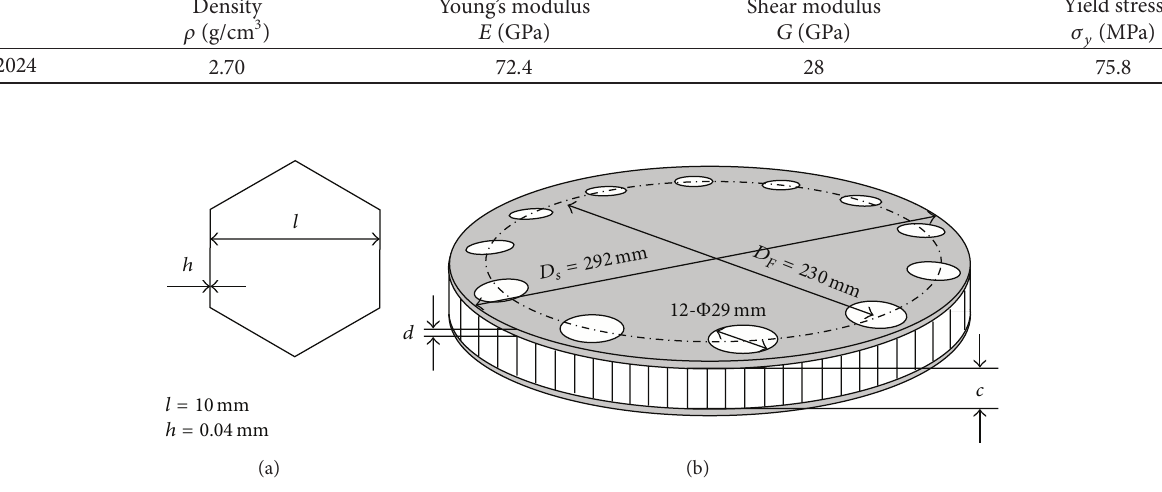
Figure 1: Geometry and dimensions of the specimens. (a) Geometry and dimension of a single cell and (b) geometry and dimension of a round sandwich